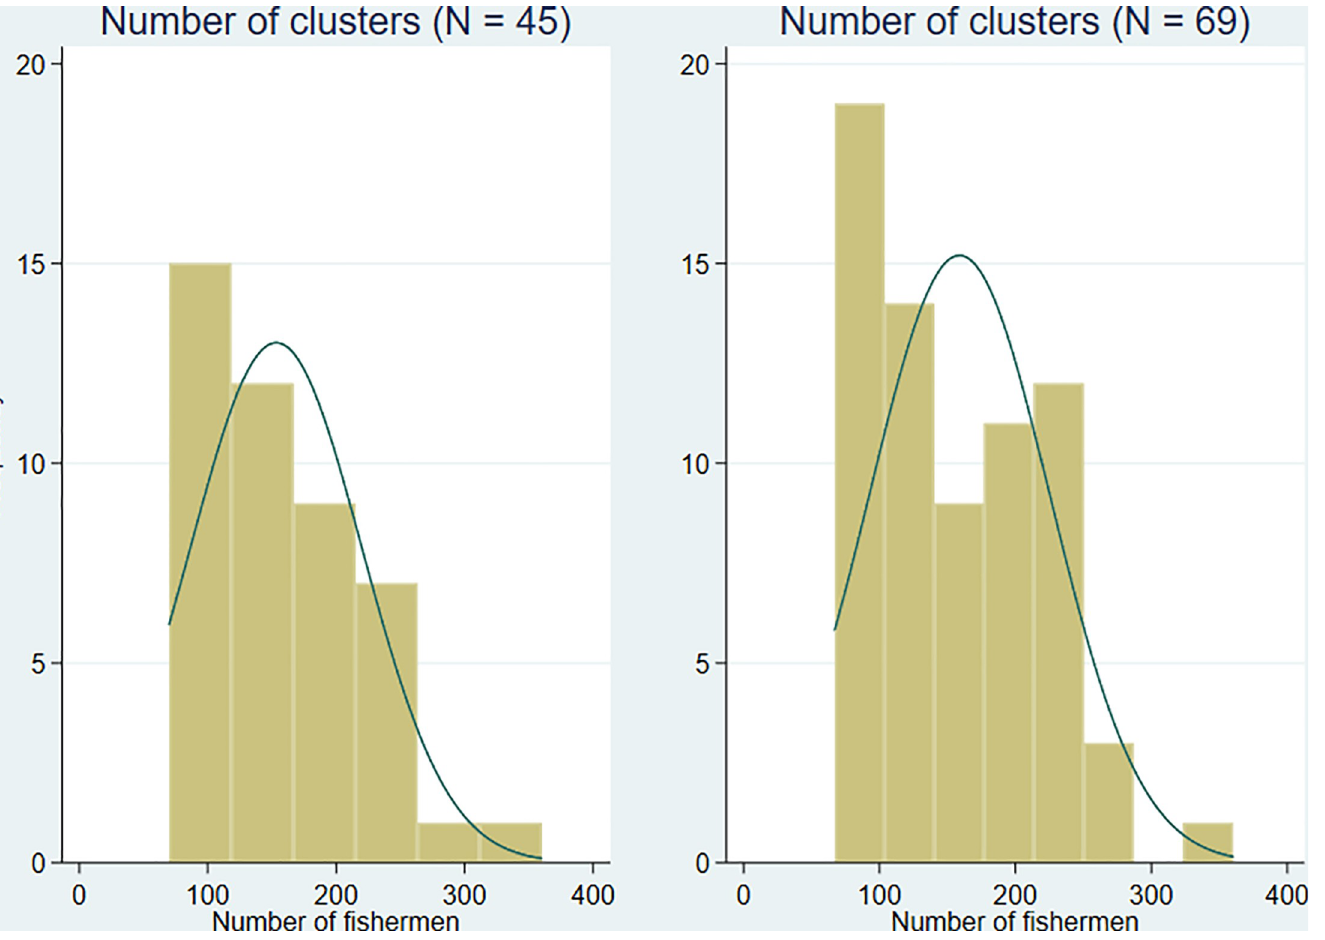
Fig 4. Distribution of number of fishermen in study